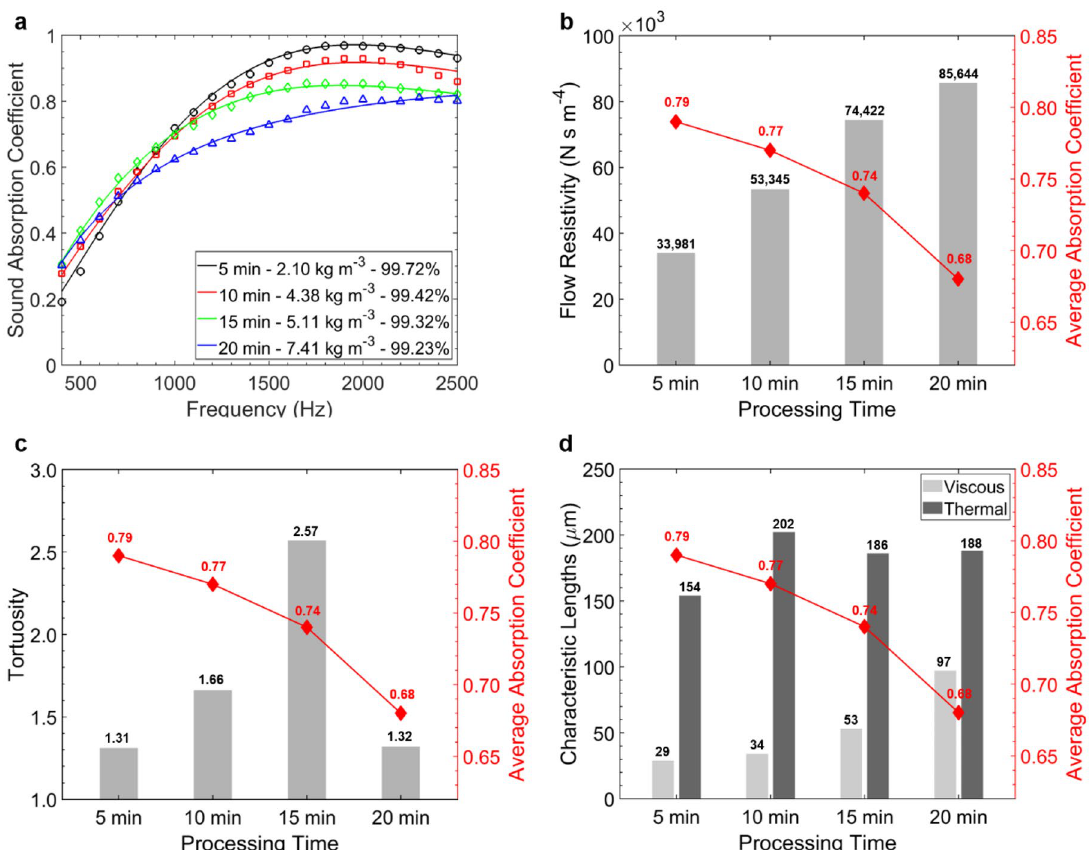
Figure 6. Semi-phenomenological analysis of GPA-1 samples with different processing times: ( a ) comparison between semi-analytical model predictions (solid lines) and experimental measurements (markers) of the sound absorption coefficient. ( b ) Flow resistivity, ( c ) tortuosity, ( d ) viscous and thermal characteristic lengths affected by processing time with average absorption coefficient